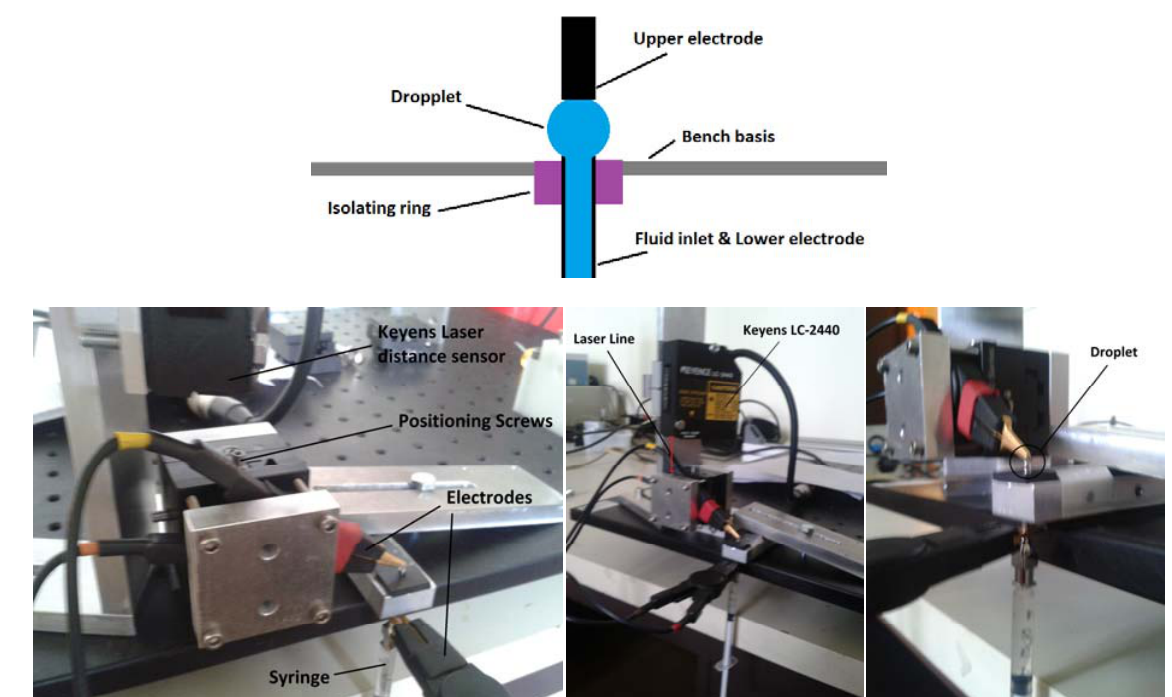
Figure 7. Resistive measurements, measuring electrodes, Keyence laser distance. Sensor & laser line, injection syringe and position of the droplet.